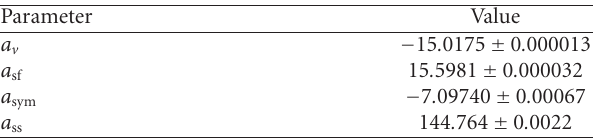
Table 1: Values for the relevant parameters in semiempirical mass formula.